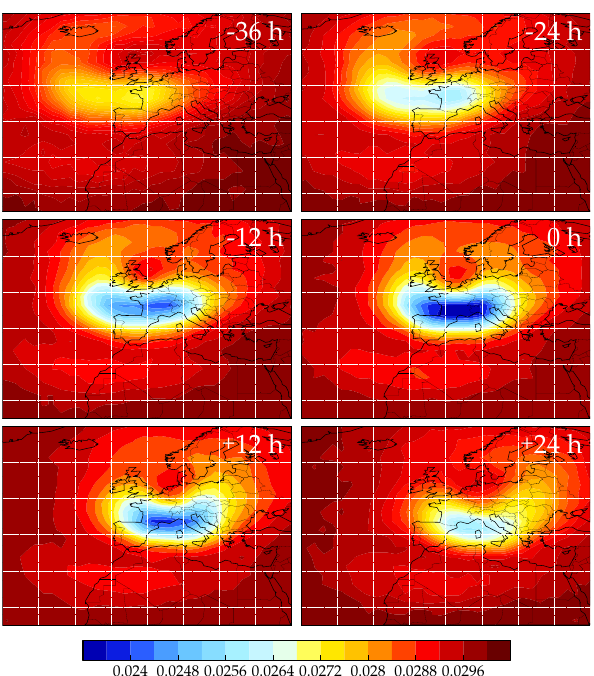
Fig. 2. Time evolution of the relevance map on the 500hPa atmo- spheric pressure level for the Binn station. The values are the CRPS scores.